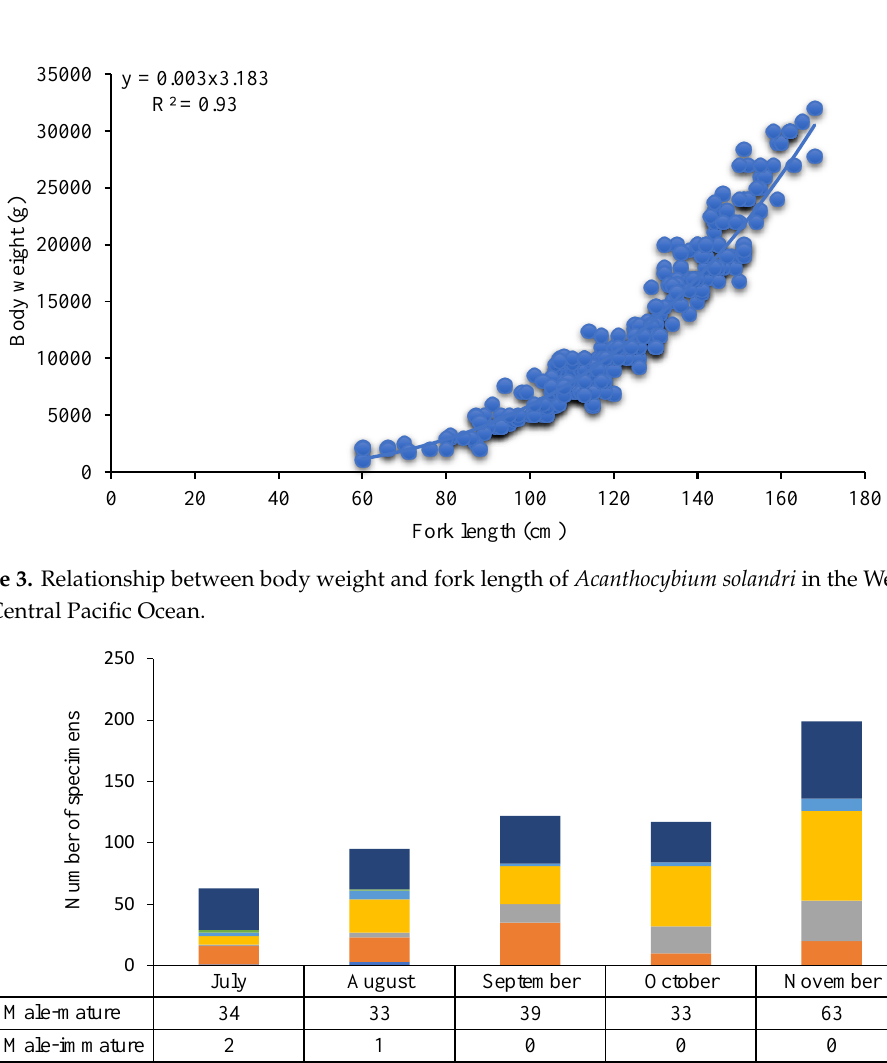
Figure 3. Relationship between body weight and fork length of Acanthocybium solandri in the Western and Central Pacific Ocean.